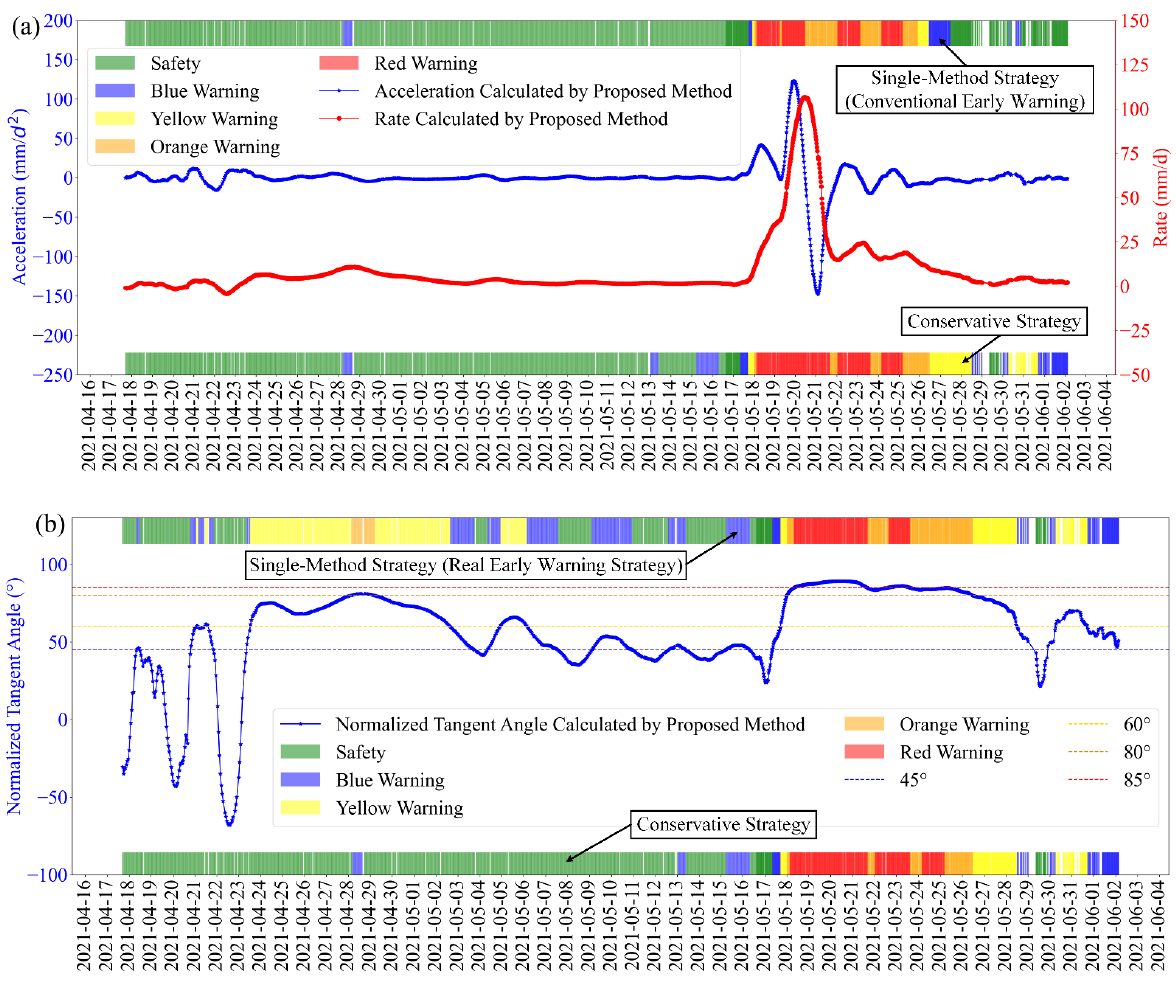
Figure 7. Early warning results of the LISHAN-DB02 monitoring station obtained by the proposed method. ( a ) Results of the conventional warning method based on velocity and acceleration. ( b ) Results of the critical sliding warning method based on the normalized tangent angle. Table 4. Key early warning events at the LISHAN-DB02 monitoring